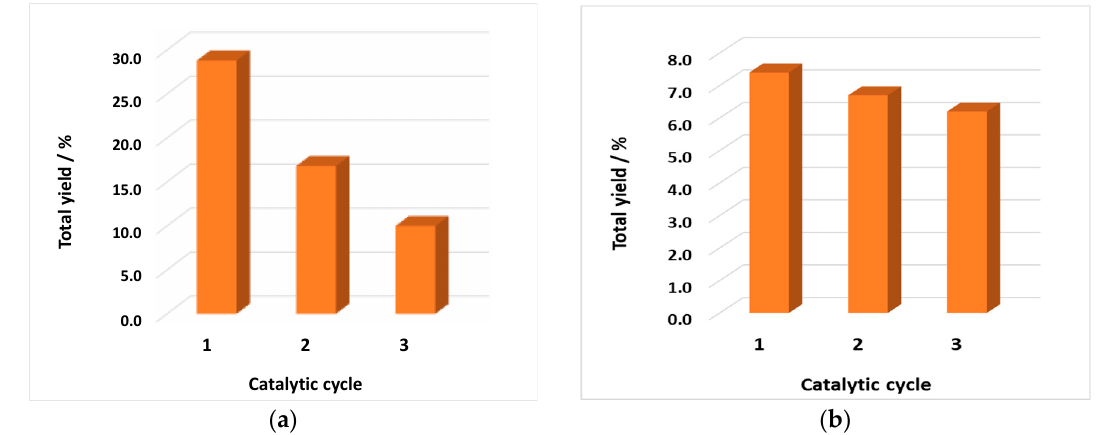
Figure 3. Effect of the magnetic mixture 2 recycling on the products yield of cyclohexane oxidation with TBHP ( a ) reaction conditions: 3 h, 50 °C, MW (5 W); ( b ) reaction conditions: 6 h, 35 °C, external magnetic field.